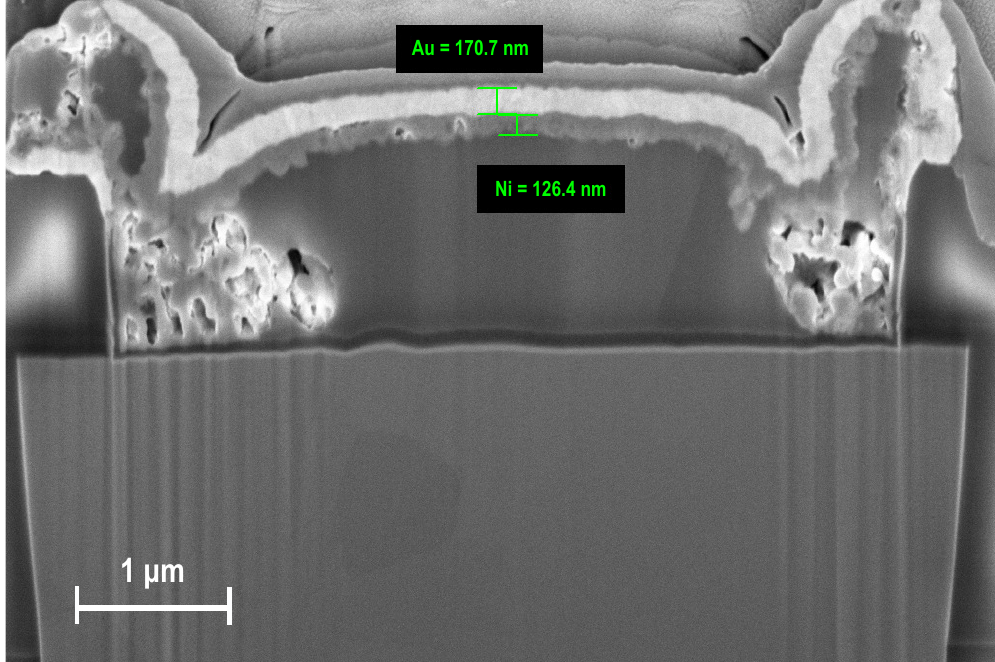
Figure 4. Cross-section FESEM image of the M4N chip. AlTEs are covered by thin layer of Nickel (126nm) and Gold (170nm). The estimated growth-rate is about 13nm/min and 17nm/min,